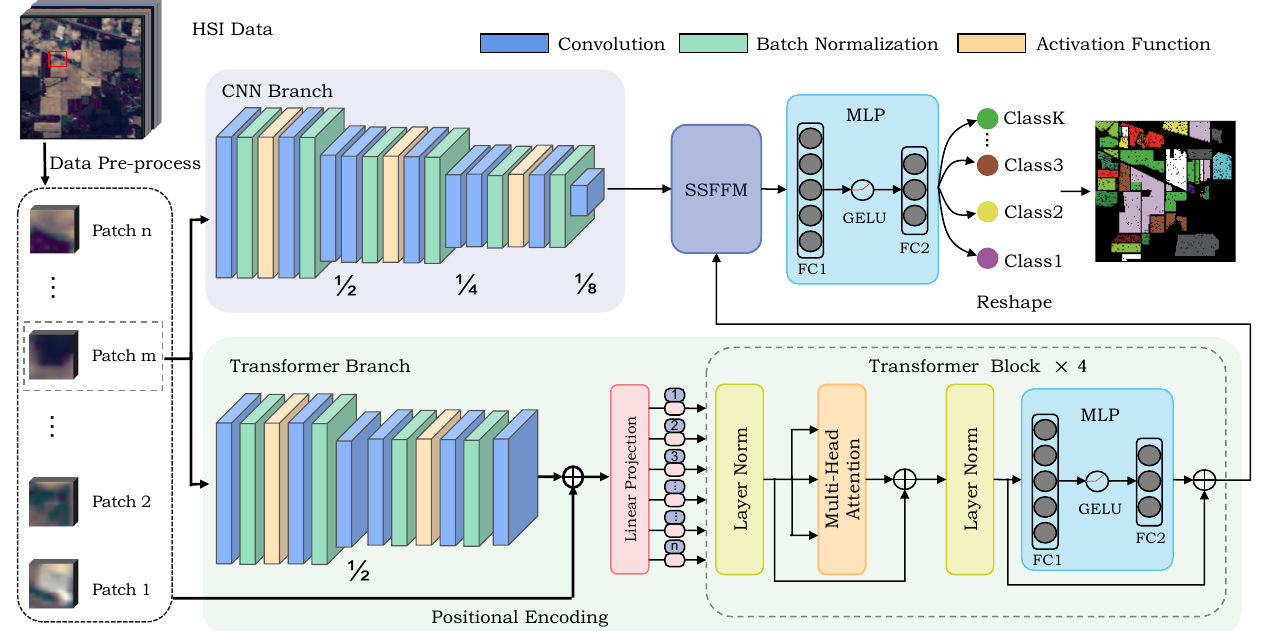
Figure 3. The architecture of the proposed